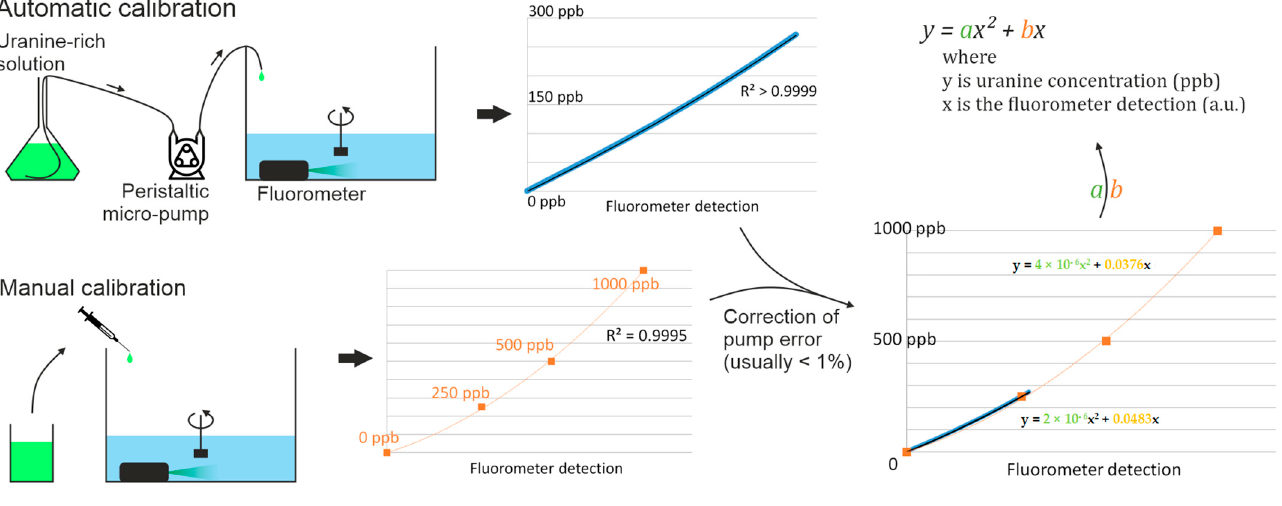
Figure 2. Automatic and manual calibrations of the fluorometers.